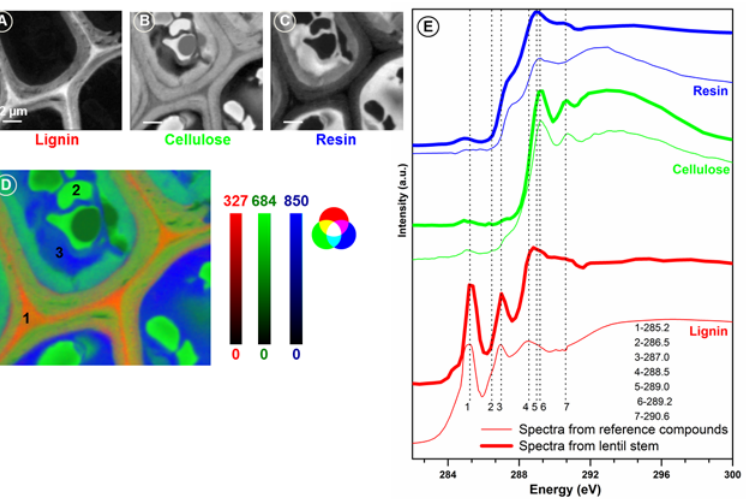
Fig 5. Mapping of lignin, cellulose, and resin in lentil stem section (A-C), and RGB composite image (D) showing the distribution of all three components in lentil stem section. Comparison of C 1s X-ray absorption spectra of reference compounds (E) with that of spectra extracted from three locations (D) on the lentil stem section. Scale bars indicate the thickness of compounds in